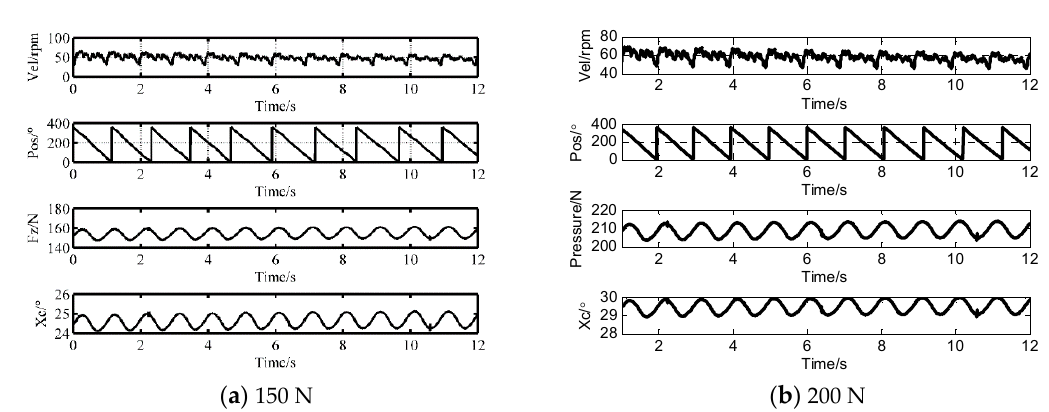
Figure 7. Time-domain analysis of dynamic pressure fluctuations and calculated contact